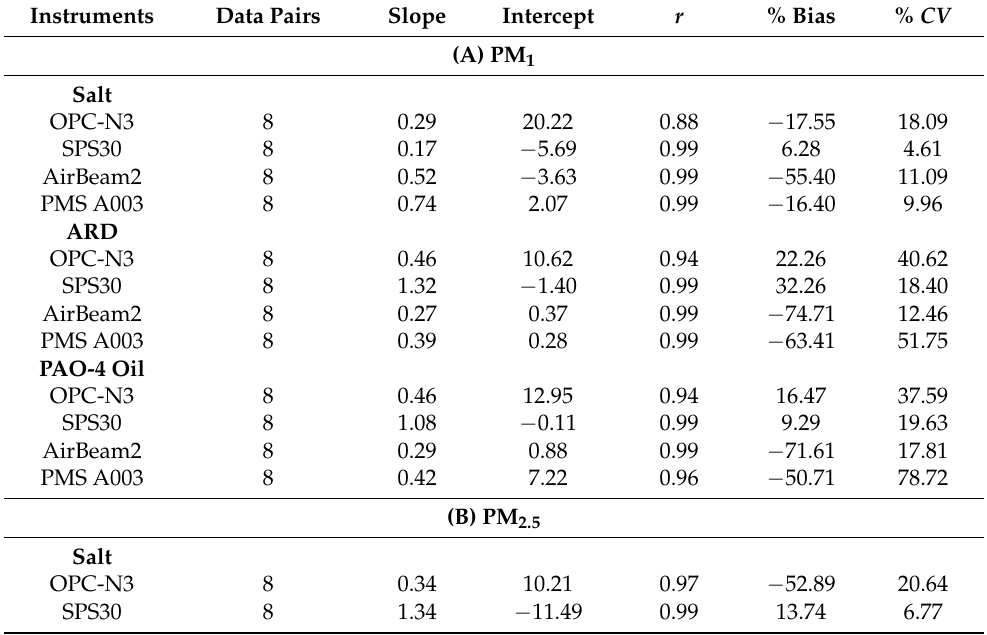
Table 3. Evaluation of mass concentrations reported by the sensors compared with the